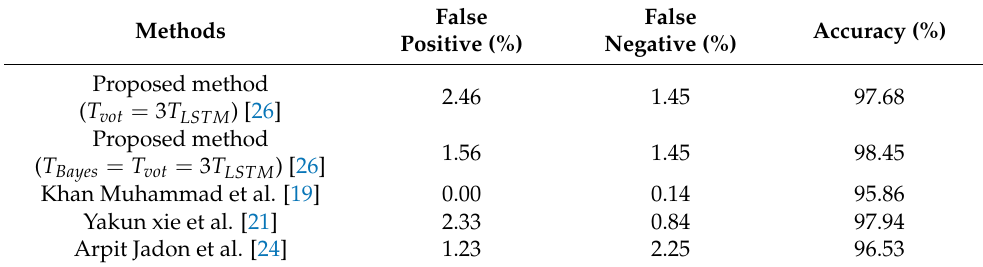
Table 10. Performance comparison with other methods.